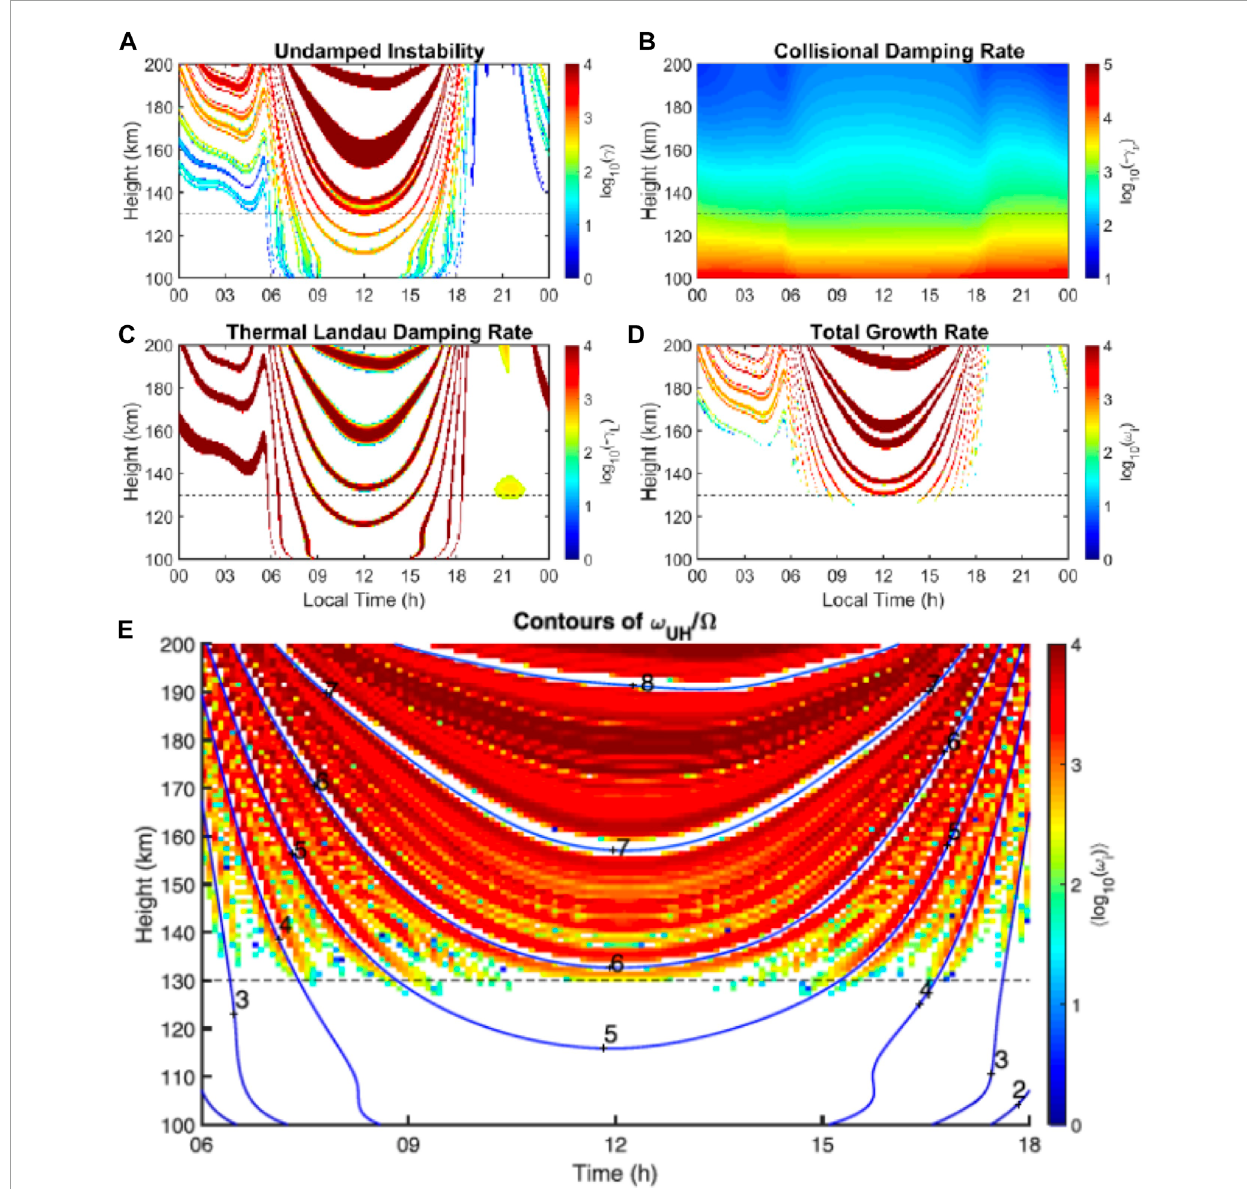
FIGURE 13 (A–D) contribution of different terms to the overall growth rate of the upper hybrid instability (UHI), with E 0 = 5 eV, λ = 20 cm, and α = 2 ° , namely: (A) Undamped instability ( γ ) , (B) collisional damping rate ( γ v ) , (C) thermal Landau damping rate ( γ Ld ) , (D) total growth rate. (E) The summation of growth rates for multiple wavelengths between 20 and 30 cm. The colored regions show where the UHI will occur. The contours of ω UH /Ω e are plotted (blue), showing that gaps in the instability occur where ω UH ≈ n Ω e . The horizontal dashed line in each plot corresponds to 130-km altitude, showing the altitude at which collisions suppress the instability (adapted from Longley et al., 2020, Figures 2,